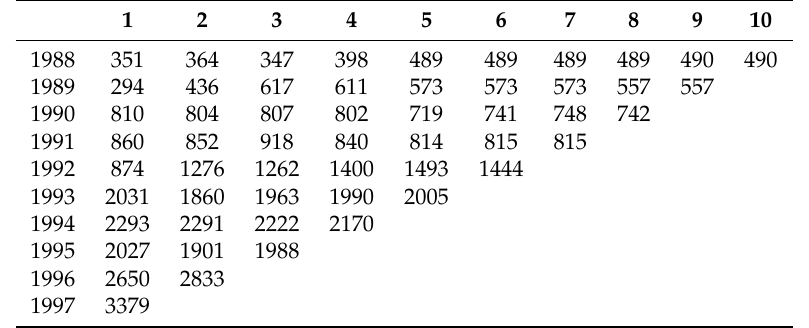
Table 6. Cumulative incurred loss triangle observed in the past (commercial auto data set, group code